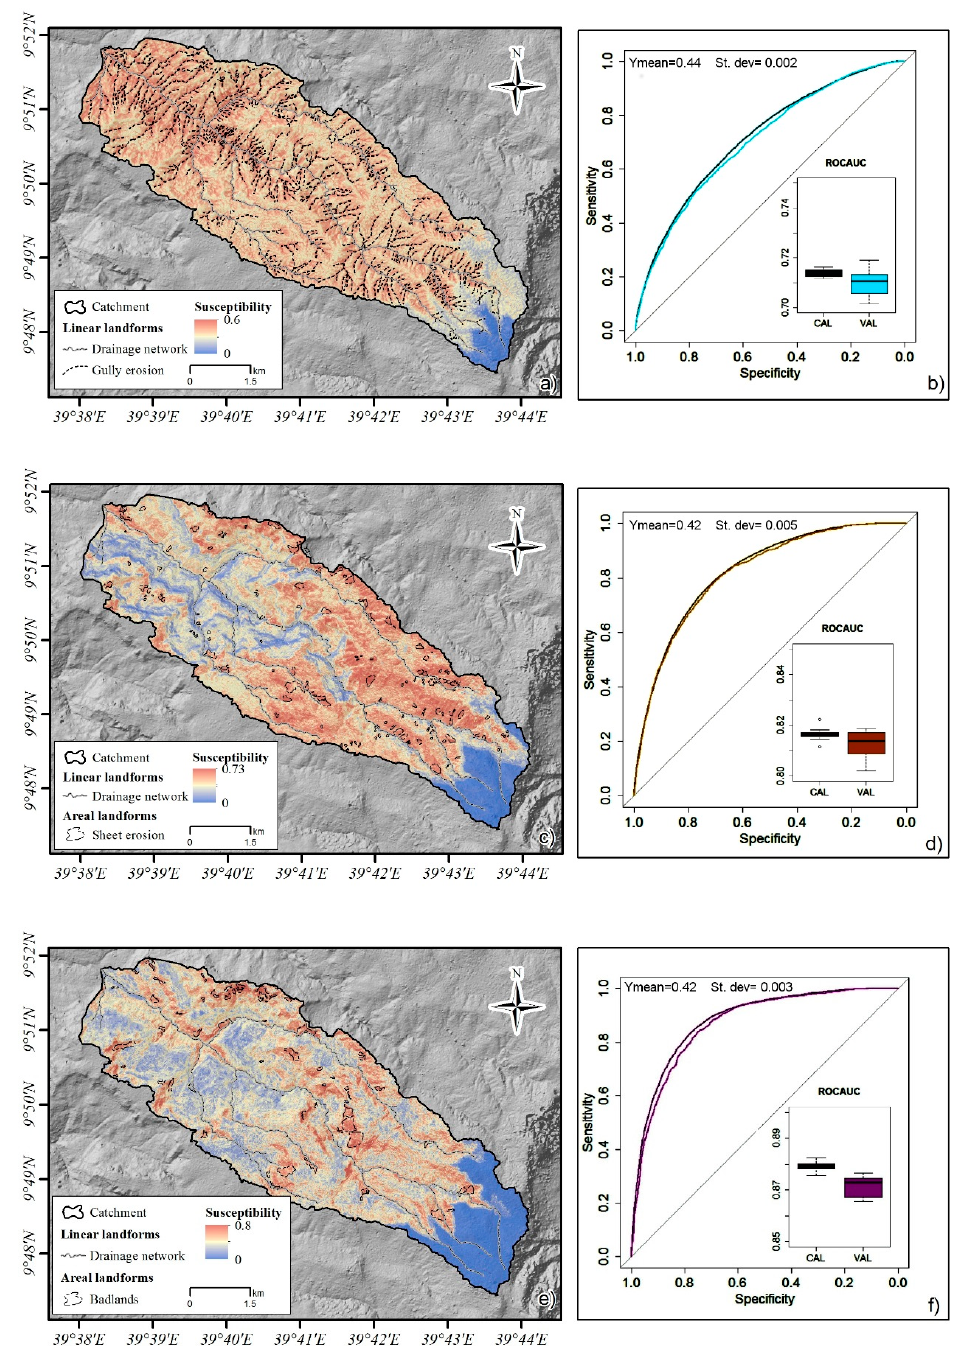
Figure 6. Susceptibility map and corresponding results of cross folded validation: ( a ) Mean susceptibility of 100 gully erosion models; ( b ) receiver operative curves and area under the curve (ROC-AUC) distribution over 100 replicates for gully erosion models; ( c ) Mean susceptibility of 100 sheet erosion models; ( d ) ROC-AUC distribution over 100 replicates for sheet erosion models; ( e ) Mean susceptibility of 100 Badland models; ( f ) ROC-AUC distribution over 100 replicates for Badlands models.